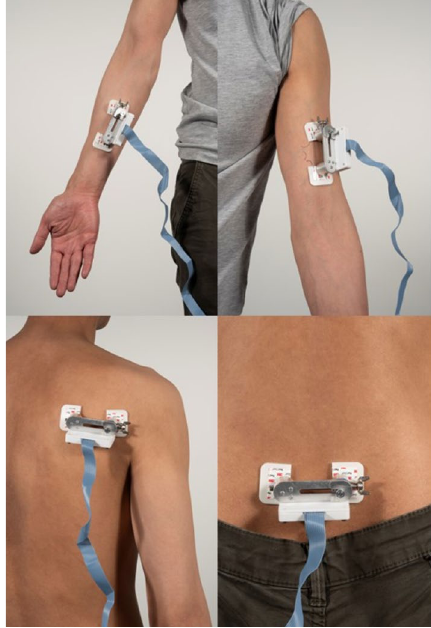
Figure 2. The postures: top left forearm, top right upper arm, bottom left shoulder blad, bottom right lower back.